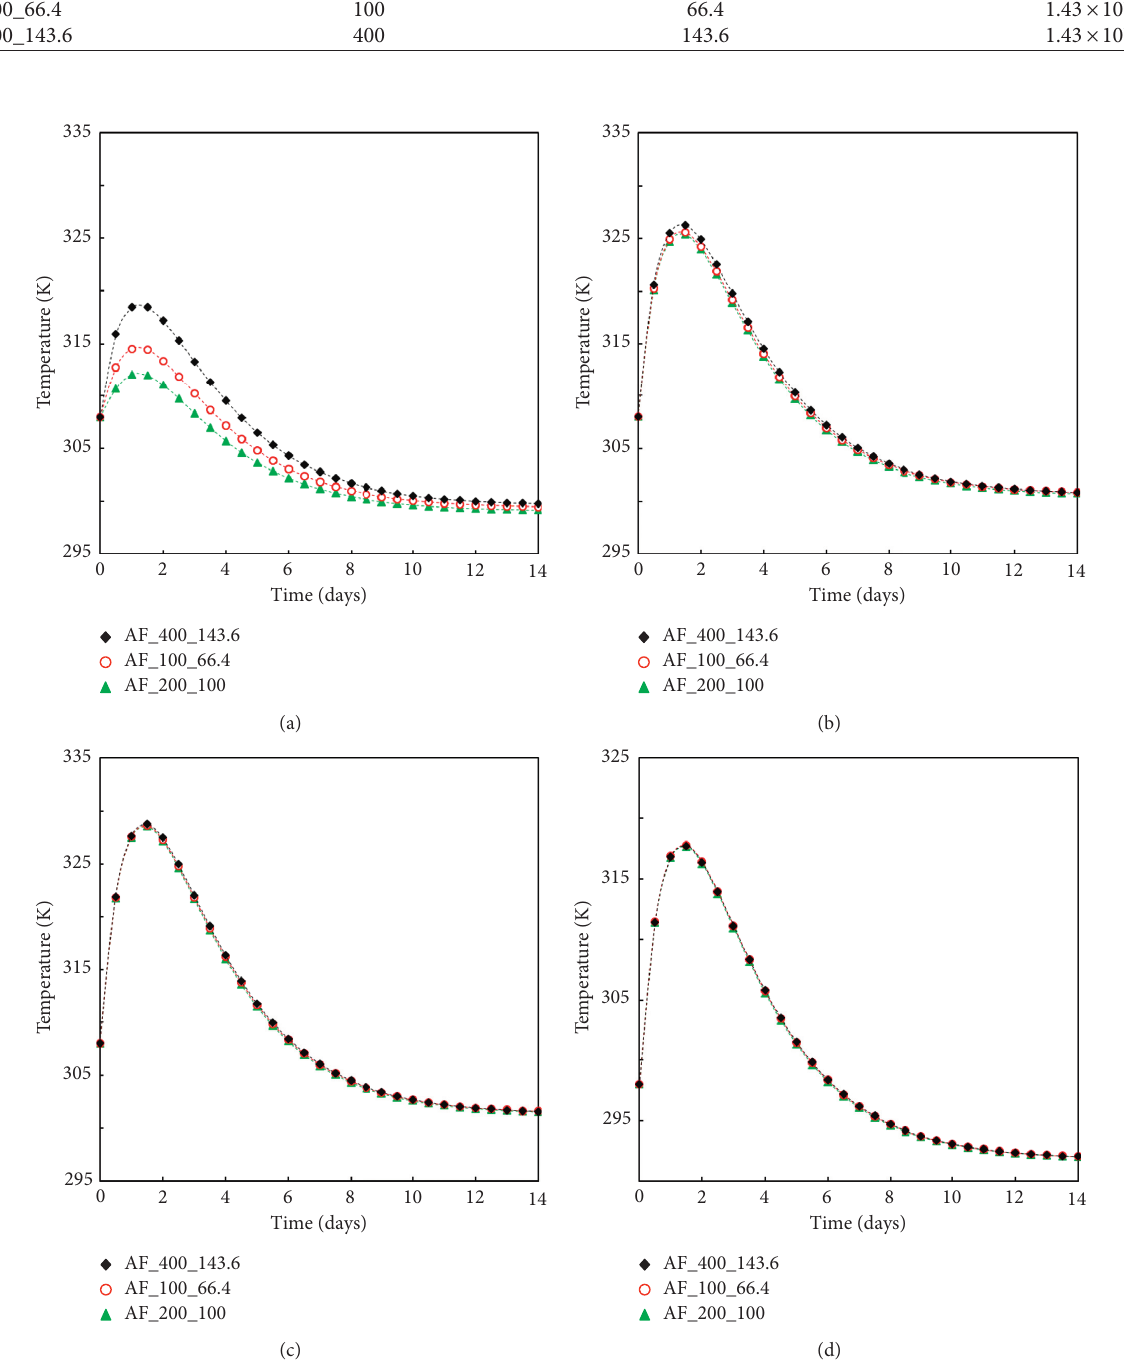
Figure 13: Temperature histories of the points with the same heat exchange area of the annular finned cooling pipe: (a) point a ; (b) point b ; (c) point c ; (d) point d .